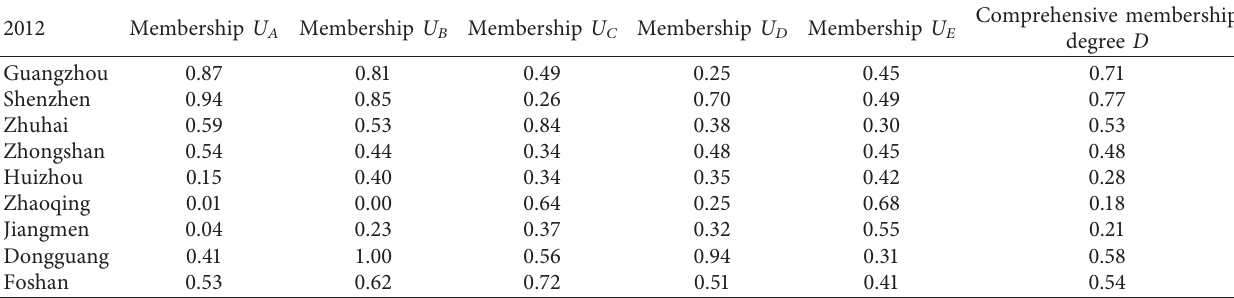
Table 11: First-level membership of the happiness index of nine cities in the Pearl River Delta in 2012.